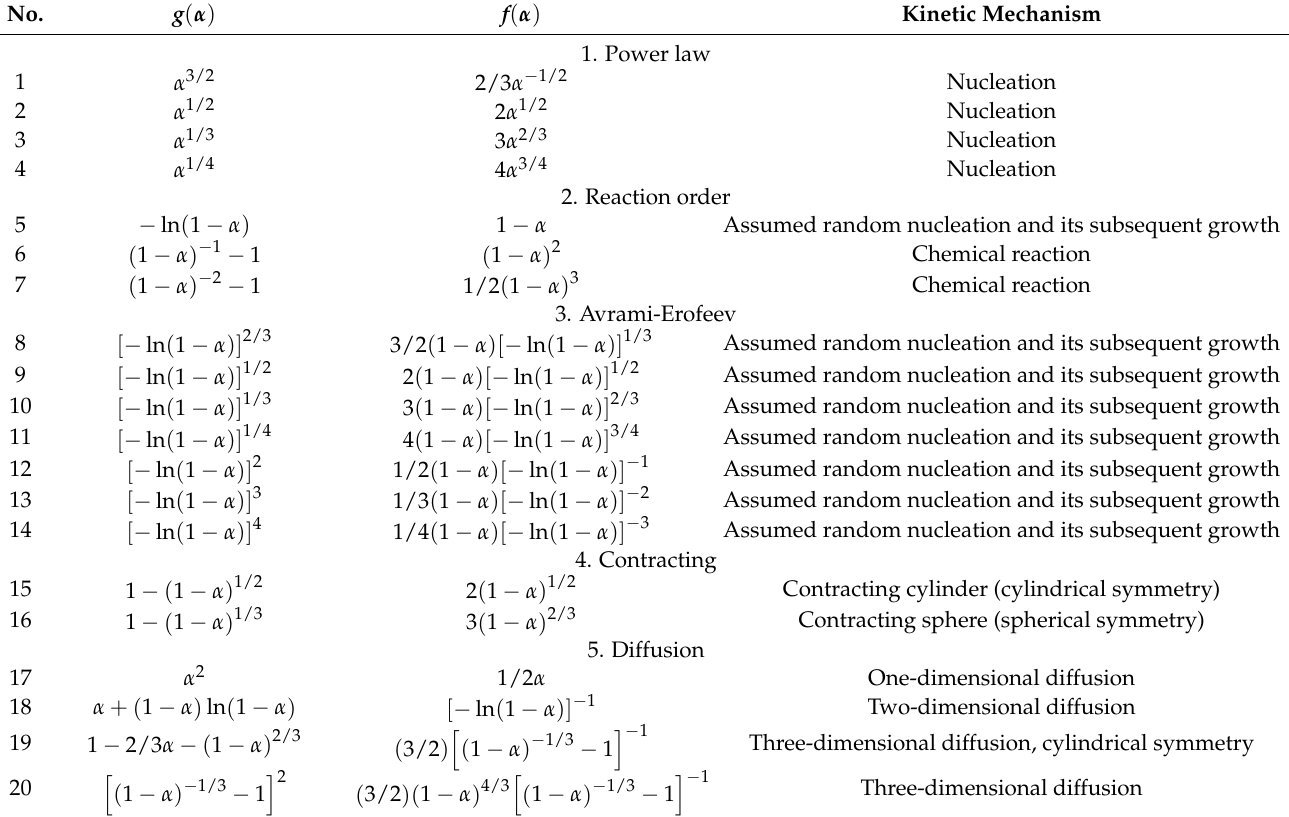
Table 1. Kinetic